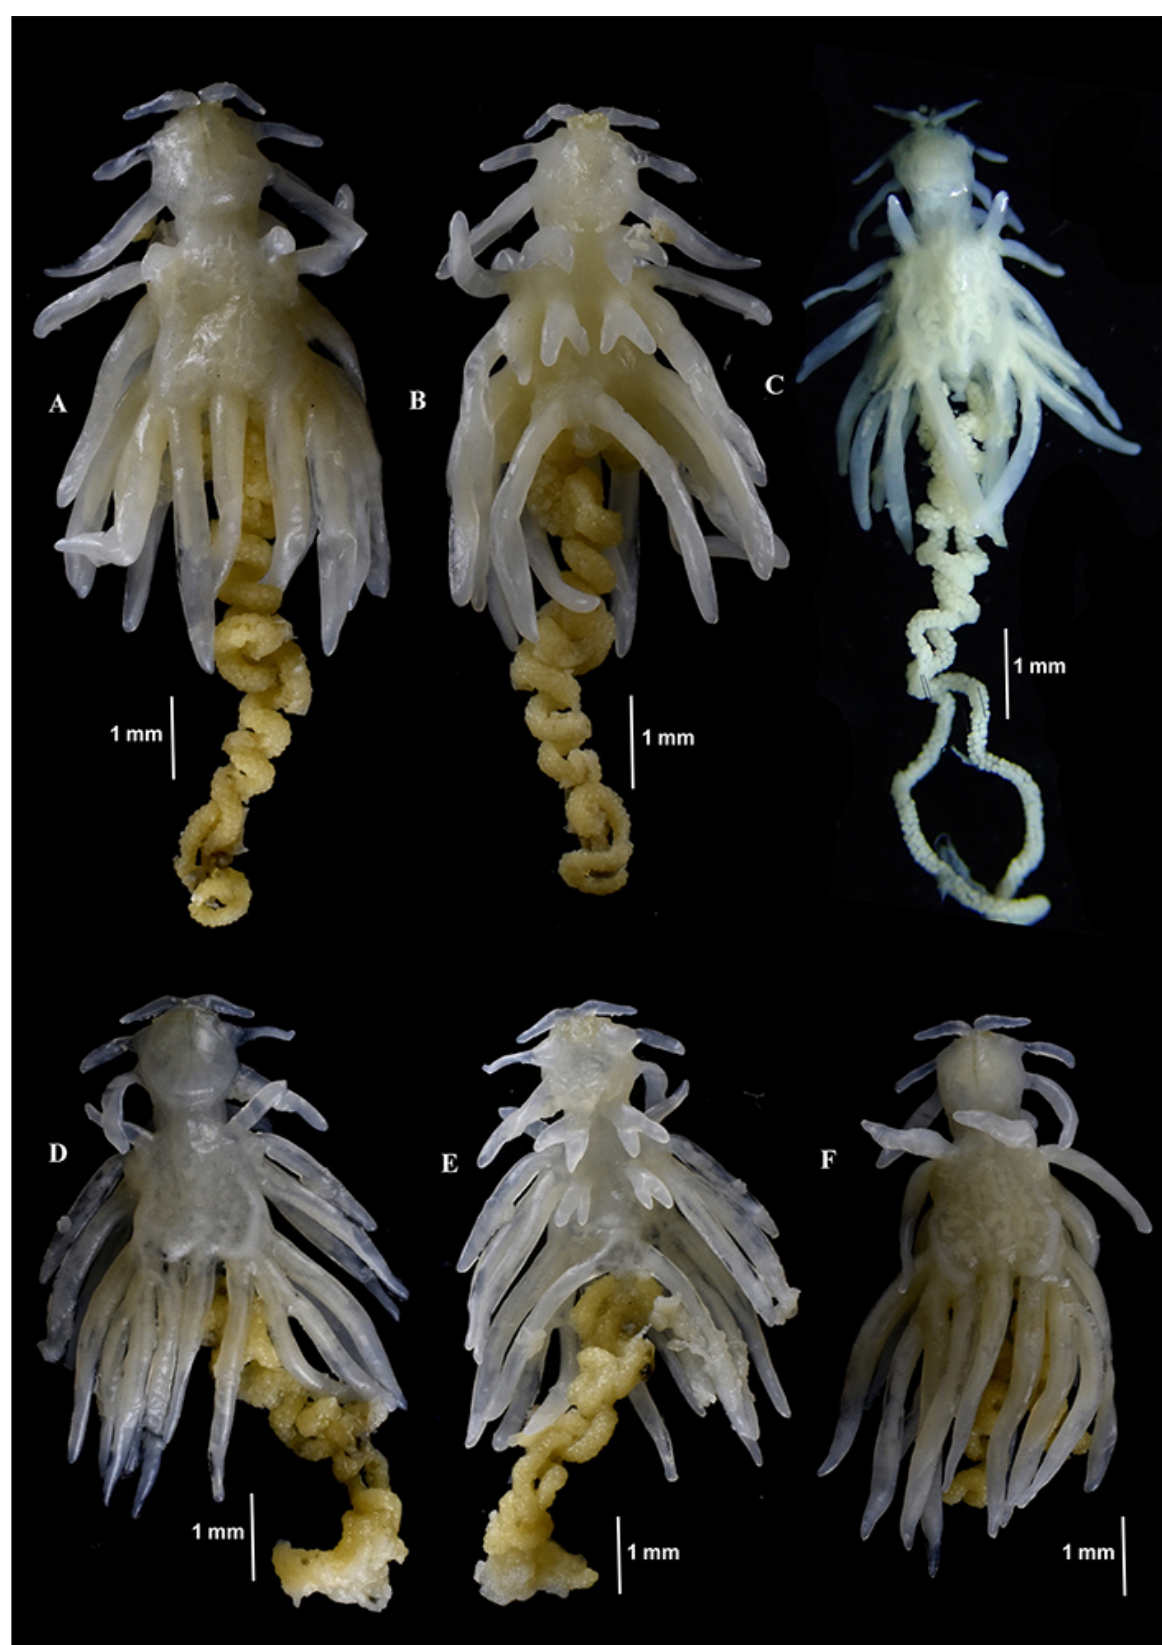
Figure 8. Chondracanthus kabatai sp. n. from Zenopsis conchifer Lowe. A – C . Holotype, female, dorsal, ventral and lateral views. D – F . Paratype, female, dorsal, ventral and dorso-lateral